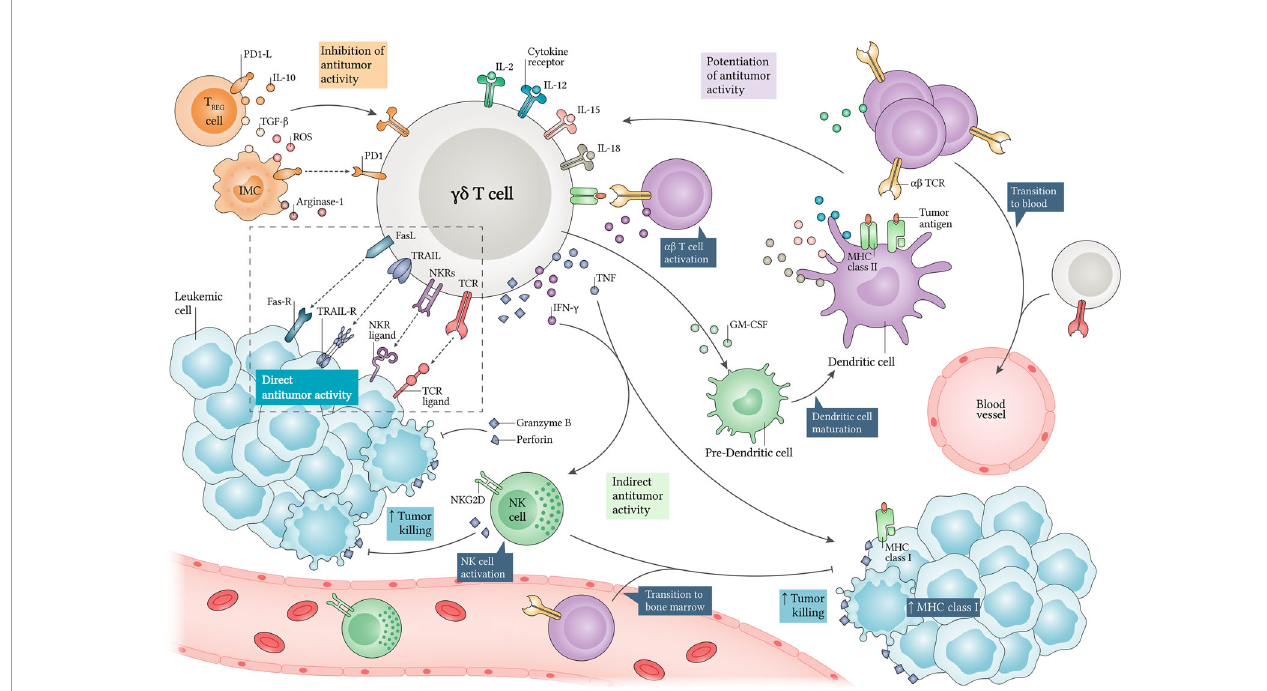
FIGURE 2 | Antileukemic roles of gd T cells and their regulation. gd T cells kill leukemic cells (LC) via direct and indirect mechanisms. When identifying LCs through gd TCR and co-receptors such as natural killer cell receptors (NKR), they secrete high levels of perforins and granzymes, mediating direct target killing. Additionally, gd T cells produce interferon (IFN)- g and tumor necrosis factor (TNF), which can increase MHC class I expression in LCs, and enhance ab T cell-mediated cytotoxicity. IFN- g release also allows NK cell activation, which can enhance tumor killing via NKG2D. Alternatively, gd T cell-derived granulocyte-macrophage colony-stimulating factor (GM-CSF) can induce dendritic cell (DC) maturation, which in turn potentiates antitumor responses via interleukin (IL)-2, IL-12, IL-15 and IL-18. Thus, ab or gd T cells and NK cells can be recruited for exerting cytotoxicity in many compartments. Moreover, gd T cells display APC functions and support ab T cell and NK cell polarization towards an antitumor phenotype. In contrast, their cytotoxicity can be decreased by regulatory T (Treg) cells and immunosuppressive myeloid cells (IMC), since they produce several inhibitory factors such as IL-10, transforming growth factor b (TGF- b ), reactive oxygen species (ROS) and Arginase-1. Finally, PD1-PD1L axis expression can regulate gd T cell antitumor activities. APC, antigen-presenting cell; FasL, Fas ligand; Fas-R, Fas receptor; PD1, programmed cell death protein 1; PD1-L, PD1 ligand; TRAIL, tumor necrosis factor-related apoptosis-inducing ligand; TRAIL-R, TRAIL